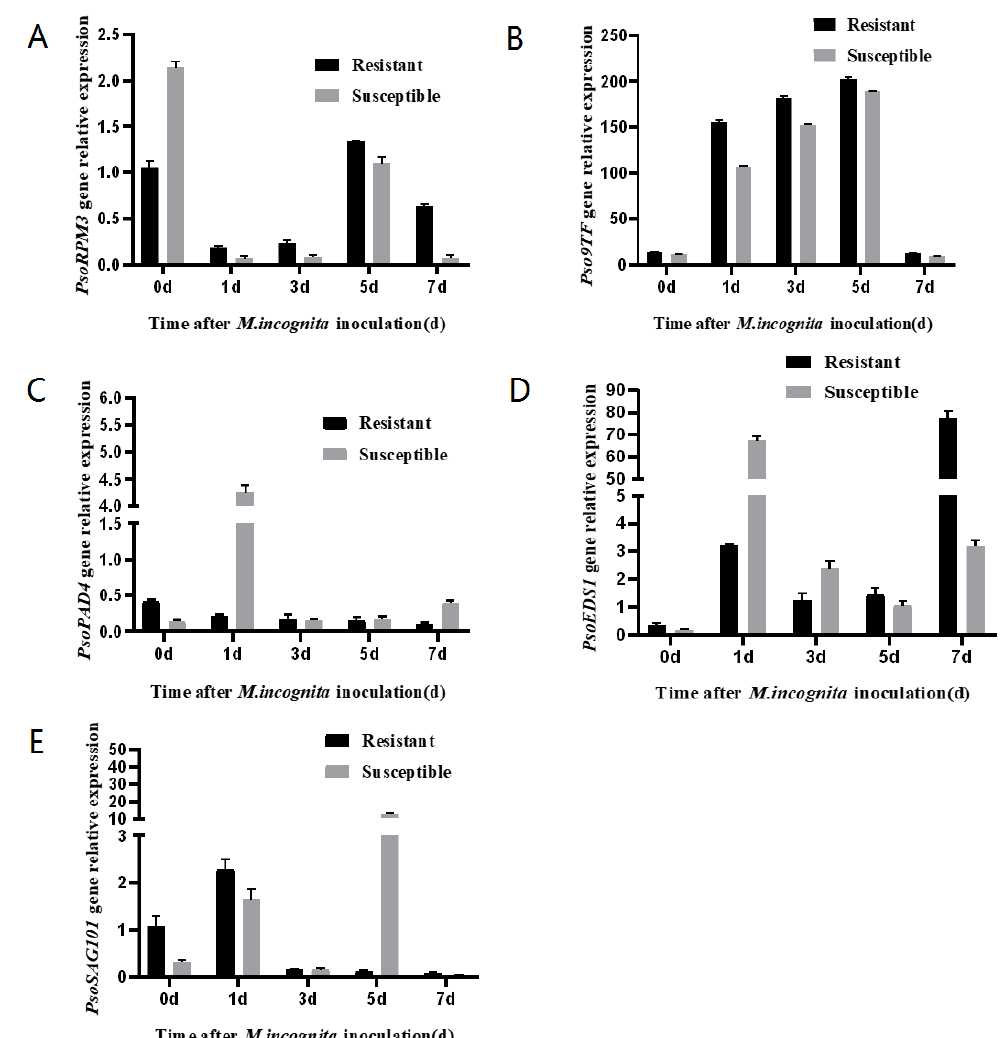
Figure 5. Expression of Pso9TF on downstream disease-resistance related genes. ( A – E ) Expression of PsoRPM3 , Pso9TF , PsoPAD4 , PsoEDS1 and PsoSAG101 in the roots of resistant and susceptible Xinjiang wild myrobalan plum ( Prunus sogdiana ) individuals at 0, 1, 3, 5, and 7 d post-infection. Real-time PCR data were calculated based on three biological and three technical replicates. Error bars = SD.